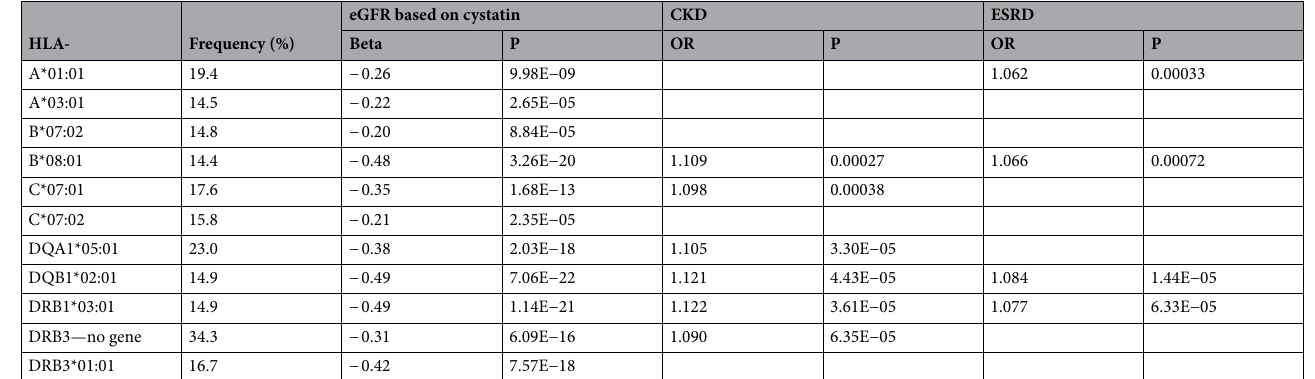
Table 4. Alleles which are associated with decreased kidney function. This shows the alleles significantly associated with decreased kidney function as well as the frequency of the alleles, the beta value or odds ratio (OR) of each effect, and the P values.